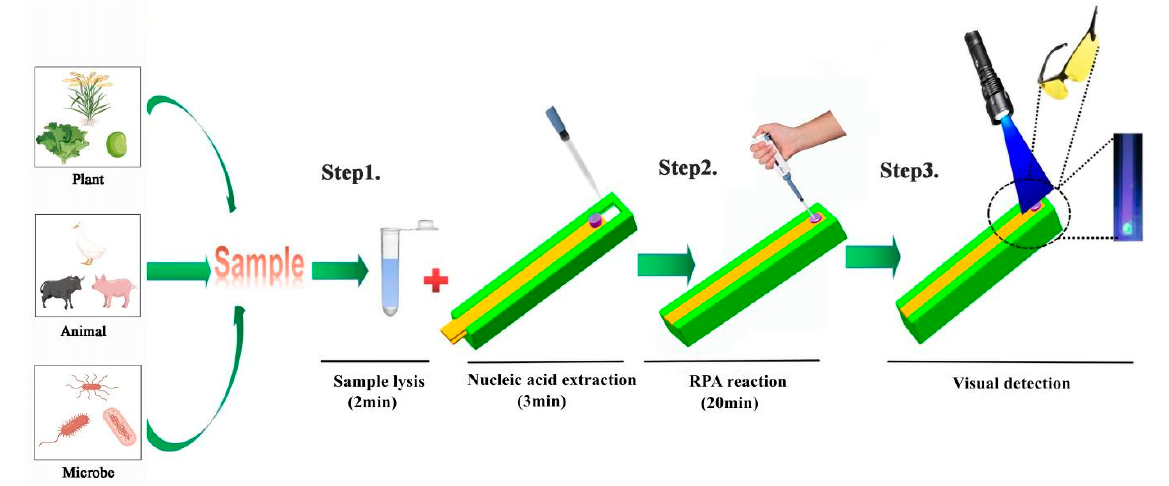
Figure 2. Operation process of SMART: Step 1 sample lysis and ultrafast DNA adsorption; Step 2 rapid amplification of target genes; Step 3 visual detection.